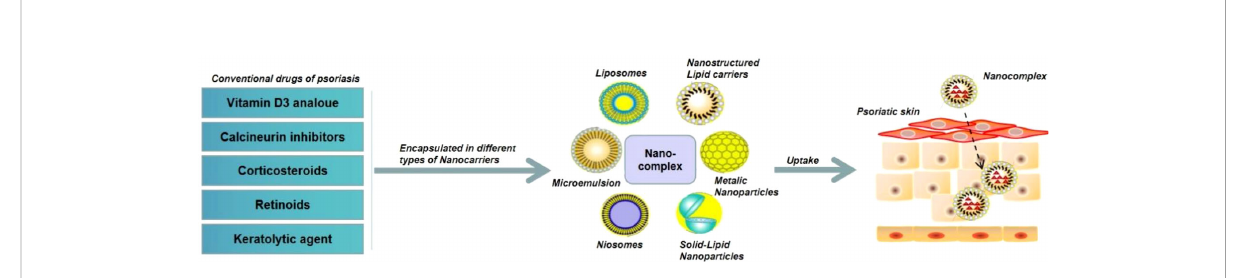
FIGURE 5 Schematic illustration of NPs-mediated delivery of small molecule drugs for the treatment of